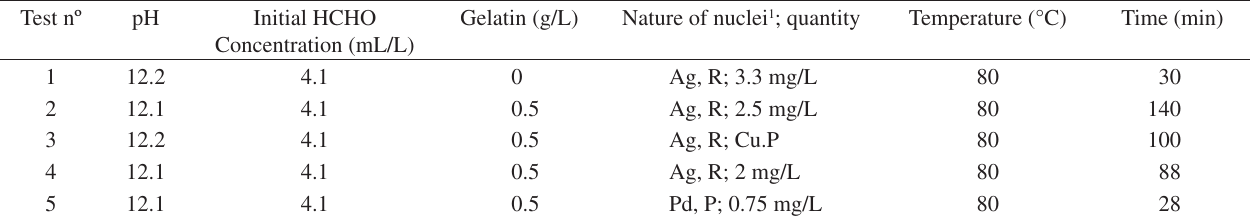
Table 1. Experimental conditions. A) Discontinuous tests.